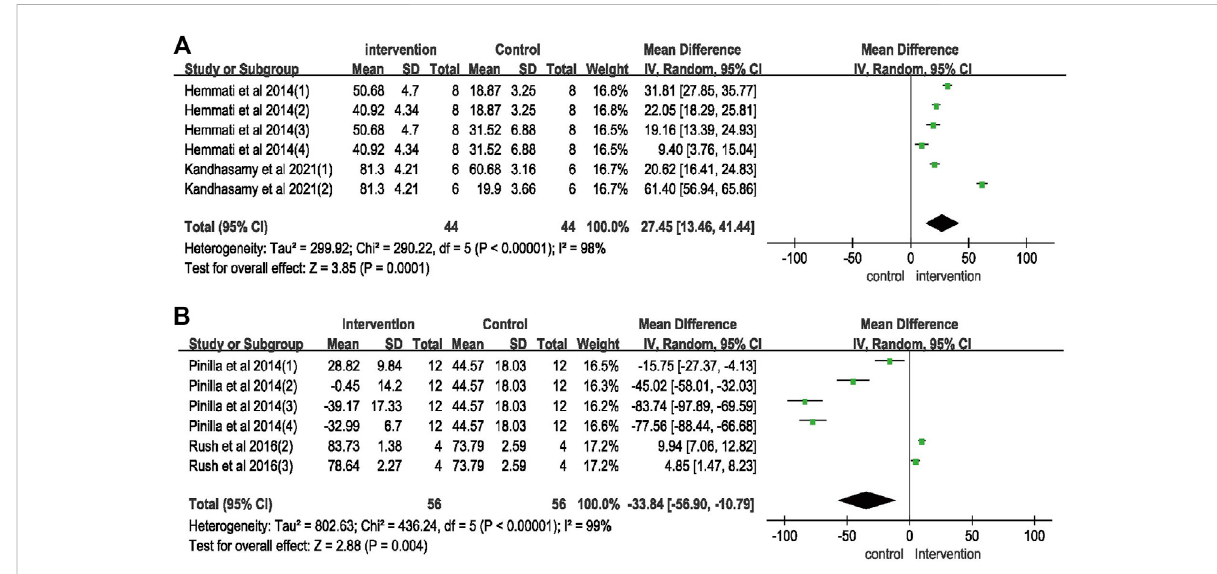
FIGURE 3 Meta-analysis on vitamin K for wound healing. (A) Wound healing rate on rat model; (B) wound healing rate on cell experiments.